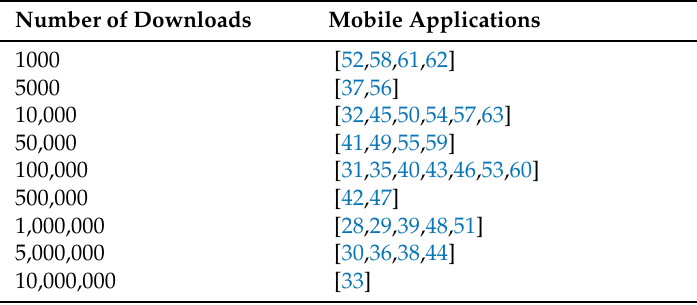
Table 3. Distribution of mobile application by number of downloads.